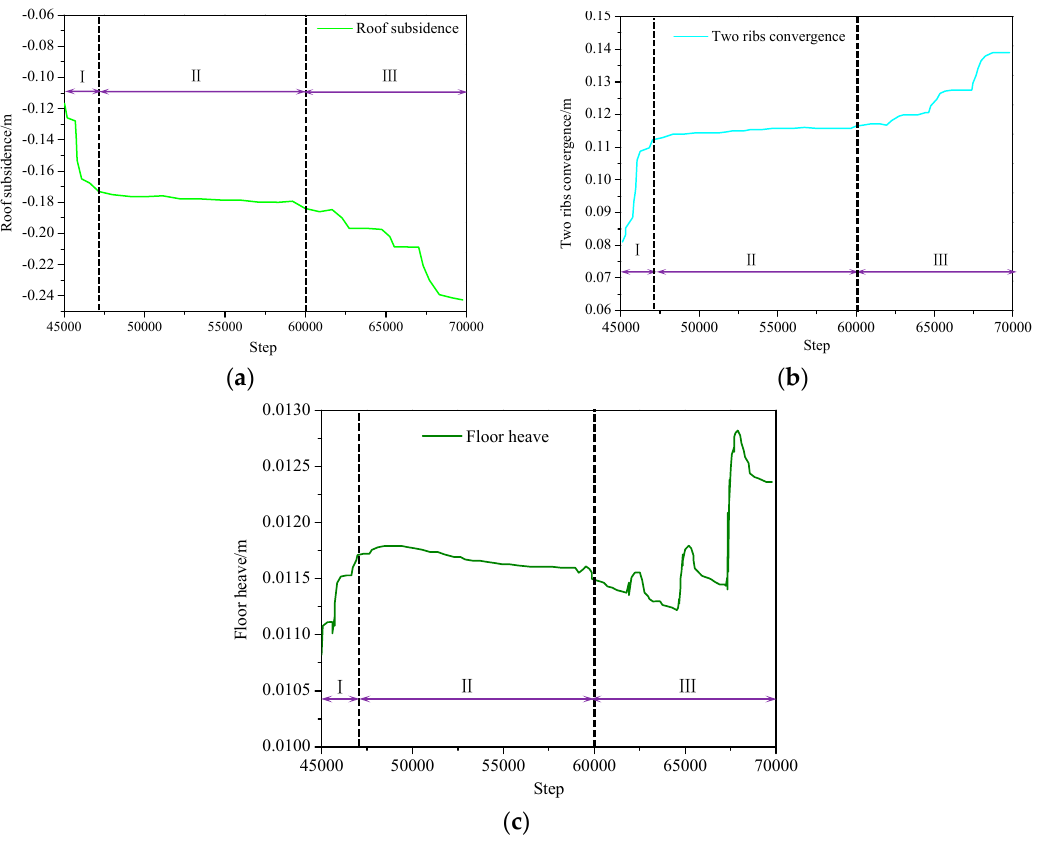
Figure 4. Variation curve of roadway deformation. ( a ) Roof subsidence; ( b ) Two ribs’ convergence; ( c ) Floor heave deformation.